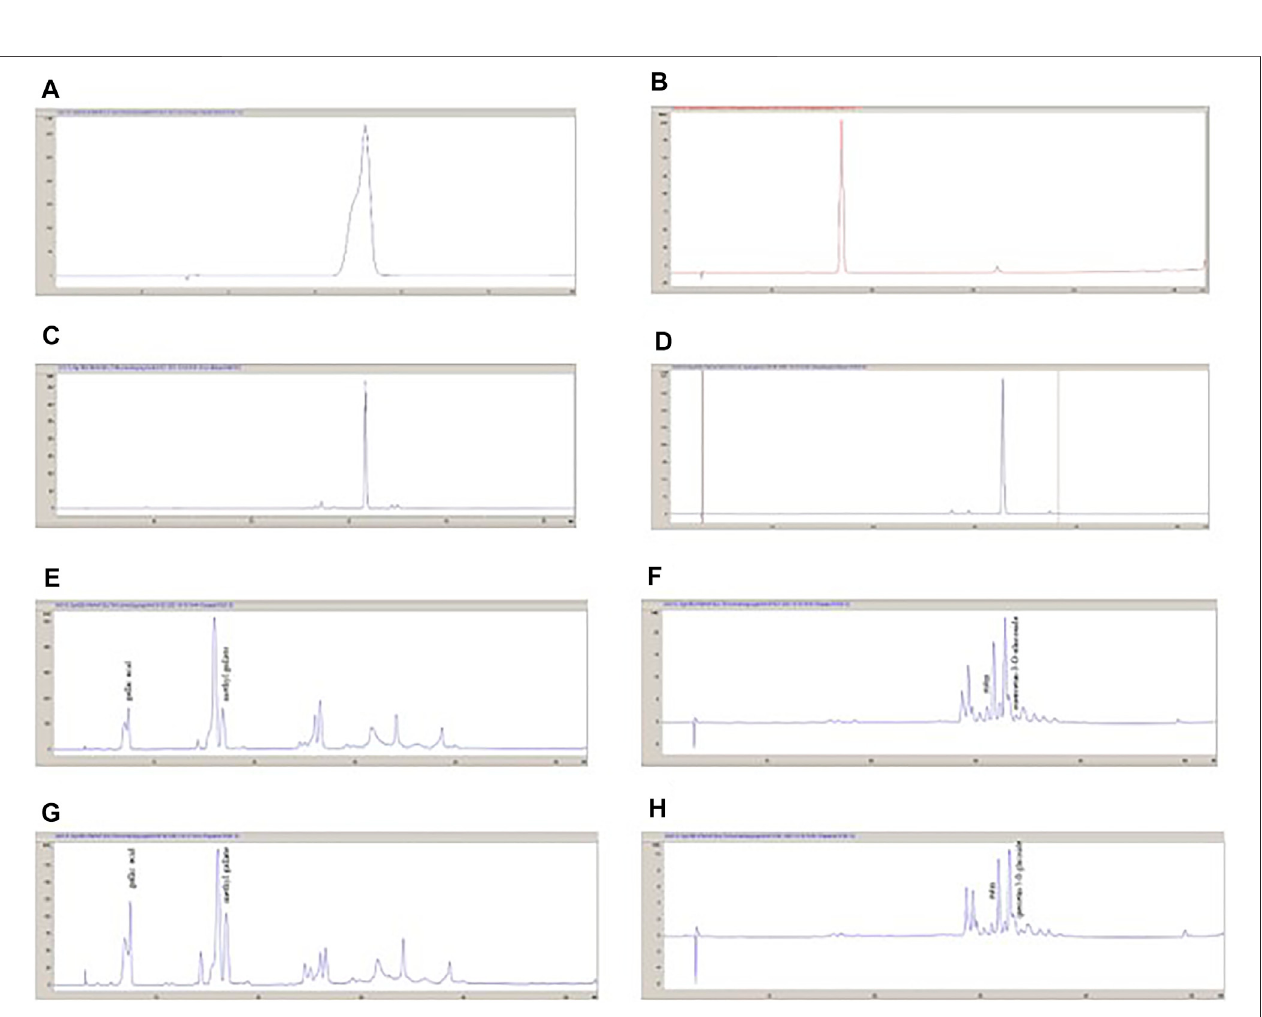
FIGURE2| TheHPLCchromatogramsofstandardcompoundsandtheextracts. (A) :Gallicacid; (B) :Methylgallate; (C) :Rutin; (D) :Quercetin-3- O -glucoside; (E) : P. atlantica EtOAc sub-extract (280 nm); (F) : P. atlantica EtOAc sub-extract (350 nm); (G) : P. atlantica crude extract (280 nm); (H) ; P. atlantica crude sub-extract (350